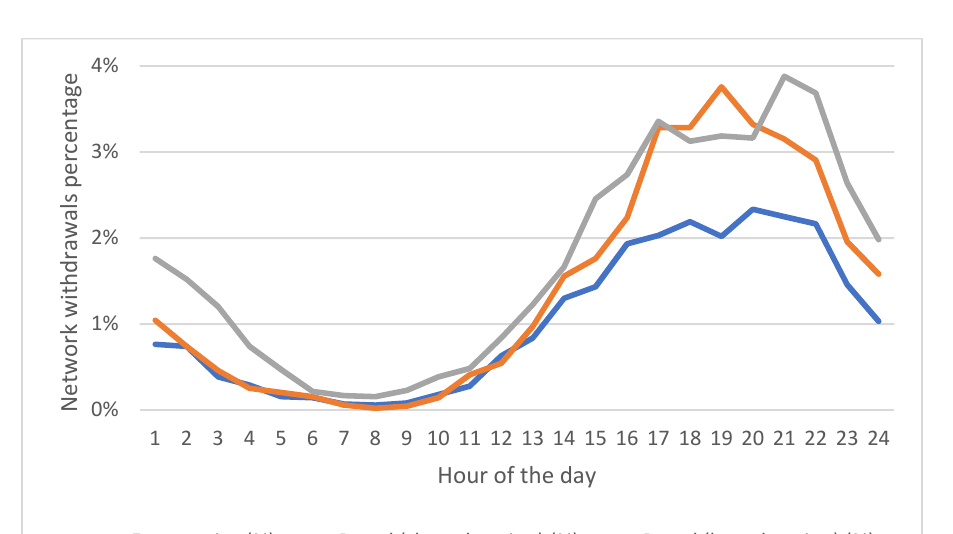
Figure 2. Percentage distribution of withdrawals per type of service and per hour of the day. The percentage distribution of withdrawals per locale, per type of service, and per hour of the day were used to simulate five different demand scenarios using the Monte Carlo Method. The models were implemented simulating the operation of one-day discretized in 48 periods of 30 min and using the five different demand scenarios and the four different voltage and electrical current settings used in laboratory tests. It was assumed a maximum limit of 20 points for the installation of terminals (Ttmax) and a limit of the number of batteries of 400 batteries for supplying the network (Tbmax). The maximum capacity of the terminals was set to be equal to 36 slots.